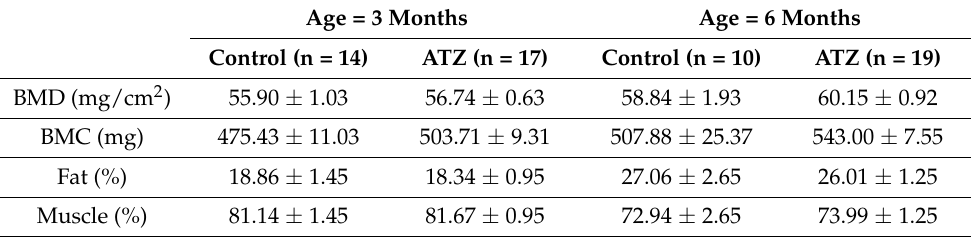
Table 4. The effect of atrazine on muscle, bone and fat properties at 3 and 6 months of age in the F2. Bone mineral density (BMD) values were multiplied by 10 4 to reflect (mg/cm 2 ). Bone mineral content (BMC) values were multiplied by 10 4 to reflect milligrams (mg). No significant differences were found between the control and ATZ treatment for all parameters. Data are mean ± SEM, with >7 L per treatment, per age cohort.